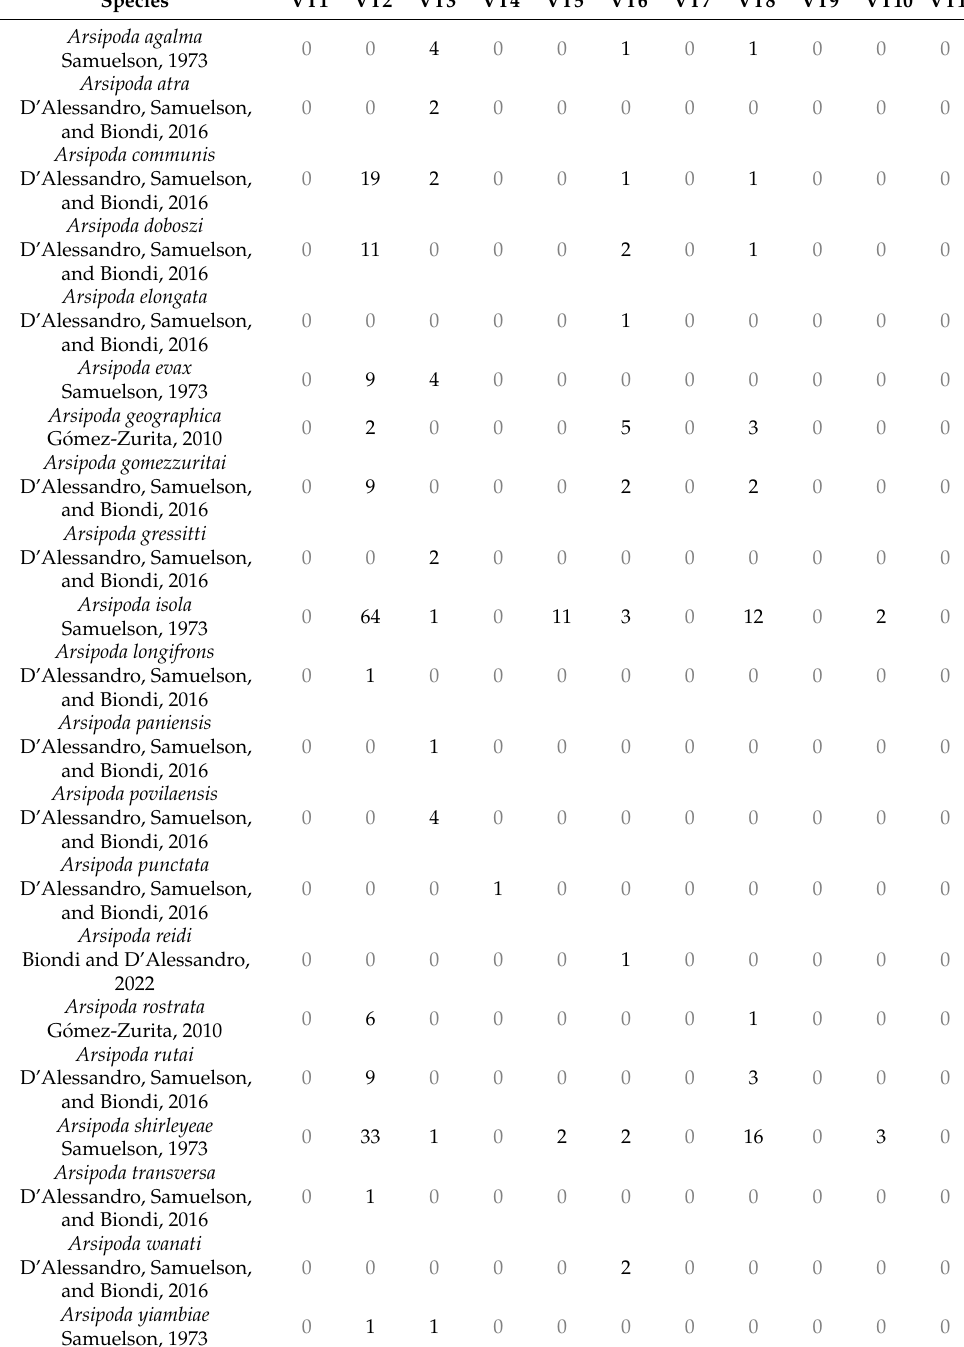
Table 1. Arsipoda species of New Caledonia and number of occurrences in vegetation types (following Jaffr é et al. [43]) coded as follows: VT1—maquis on siliceous rock at low to middle elevation; VT2—maquis on ultramafic rock at low to middle elevation; VT3—dense, humid forest on volcano sediments at low to middle elevation; VT4—mangroves and saline vegetation at low elevation; VT5 —savanna and secondary brushwood; VT6—dense, humid forest and maquis at high